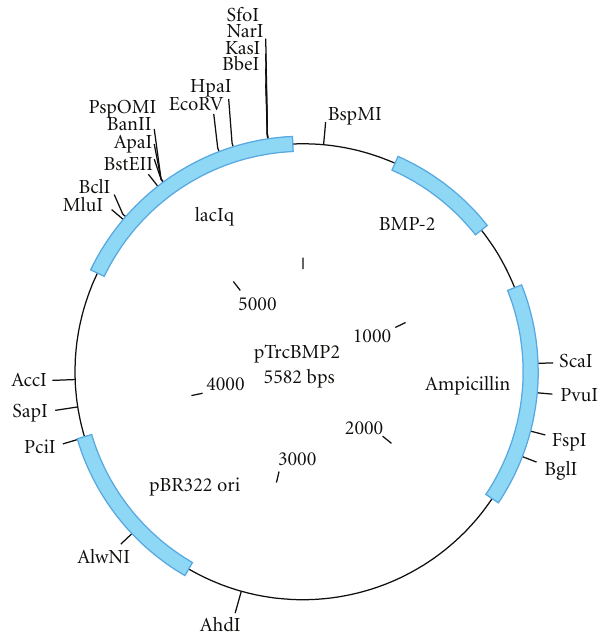
Figure 2: Schematic layout of the pTrcHis TOPO TA expression vector (Invitrogen, Netherland) used in this study for prokaryotic expression and the strategy employed to insert the ileal-derived human BMP-2 in this vector. The same vector, but driving LacZ expression, was used as control